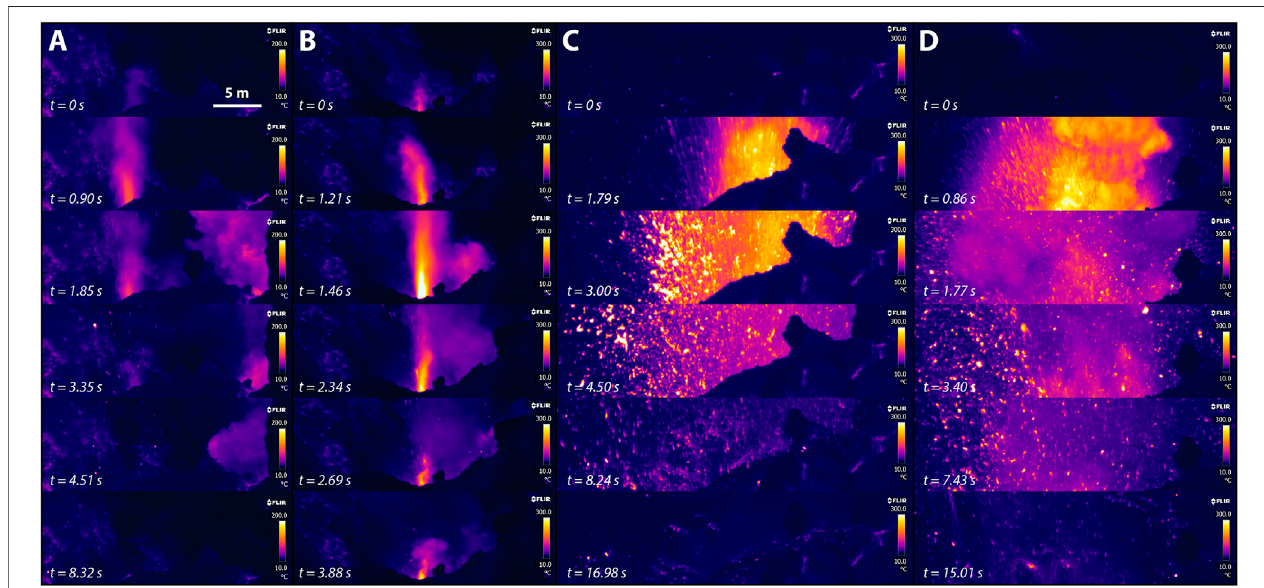
FIGURE 5 | Sequences of images of four explosions in the South West (SW) crater, recorded with the Forward Looking Infra-Red (FLIR) camera. (A) Type 0 explosion recorded the 27 July at 13:43 (all times quoted in this paper are local times). At t (cid:2) 0 s, only intermittent gas puf fi ng is observed; between t (cid:2) 0.90 s and t (cid:2) 1.85 s, the explosion begins, a gas jet is visible with temperature up to 200 ° C, with the synchronous emission of scarce particles; between t (cid:2) 3.35 s and t (cid:2) 4.51 s, the gas jet decreases, still with the emission of scarce particles; at t (cid:2) 8.32 s, the explosion ends. (B) Type 0 explosion recorded the 27 July at 16:26. At t (cid:2) 0 s, only intermittentgaspuf fi ngisobserved;between t (cid:2) 1.21 sand t (cid:2) 1.46 stheexplosionbegins,agasjetisvisiblewithtemperaturemorethan300 ° C;between t (cid:2) 2.34 sand t (cid:2) 2.69 s,the gasjet decreasesin intensity with the emission ofveryscarce particles; at t (cid:2) 3.88 s, the gasjet ends. (C) Type 1explosion recordedthe 29Julyat 14:44. At t (cid:2) 0 s,noparticlesandnogaspuf fi ngarevisible;at t (cid:2) 1.79 s,theexplosionstartswiththeemissionofalotofparticles;at t (cid:2) 3.00 s,theexplosionsintensityreachits maximumintermofpyroclastmassemission;between t (cid:2) 4.50 sand t (cid:2) 8.24 stheexplosiondecreases;at t (cid:2) 16.98 s,theexplosionendswithstillhotpyroclastsonthe craterwalls. (D) Type1/2explosionrecordedthe29Julyat16:16.At t (cid:2) 0 s,noparticlesandnogaspuf fi ngarevisible;at t (cid:2) 0.86 s,theexplosionstartswiththeemission of alot ofparticles with adistinguishable small ash and/or gasplume;between t (cid:2) 1.77 s and t (cid:2) 7.43 s theexplosion oscillates in term of intensity with the emission ofa lot of relatively fi ne particles (lapilli); at t (cid:2) 15.01 s, the explosion ends with still hot pyroclasts on the crater